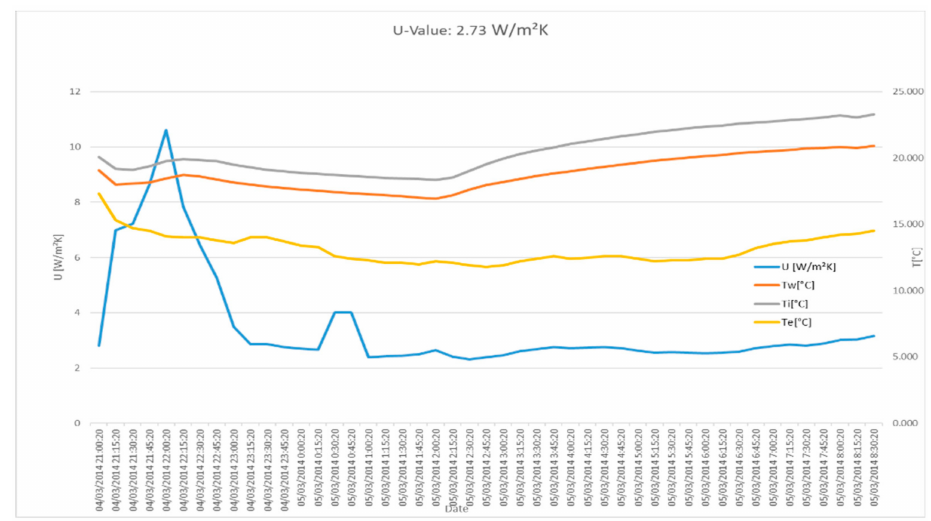
Figure 9. Dwelling envelope thermal transmittance test before